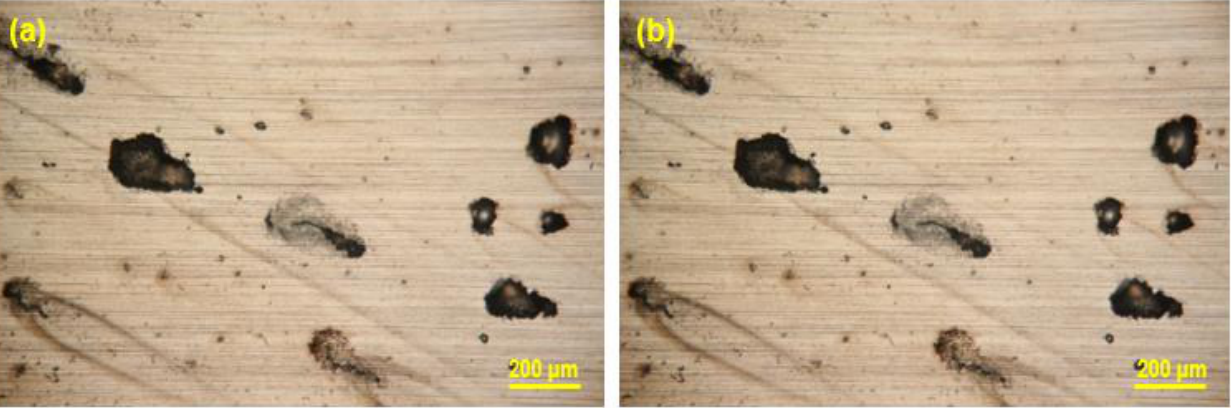
Figure 10. Optical micrographs for AISI 304L after potentiodynamic polarization measurements in seawater at ( a ) 288 K and ( b ) 308 K and for AISI 316L at ( c ) 288 K and ( d ) 308 K (100 × magnification).